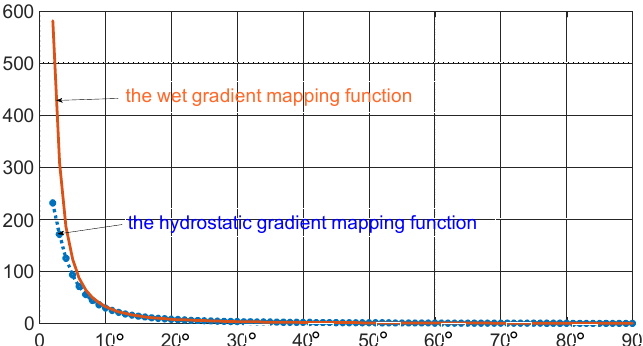
Figure 5. The hydrostatic and wet gradients mapping functions using equations given by Chen, et al. [44] .